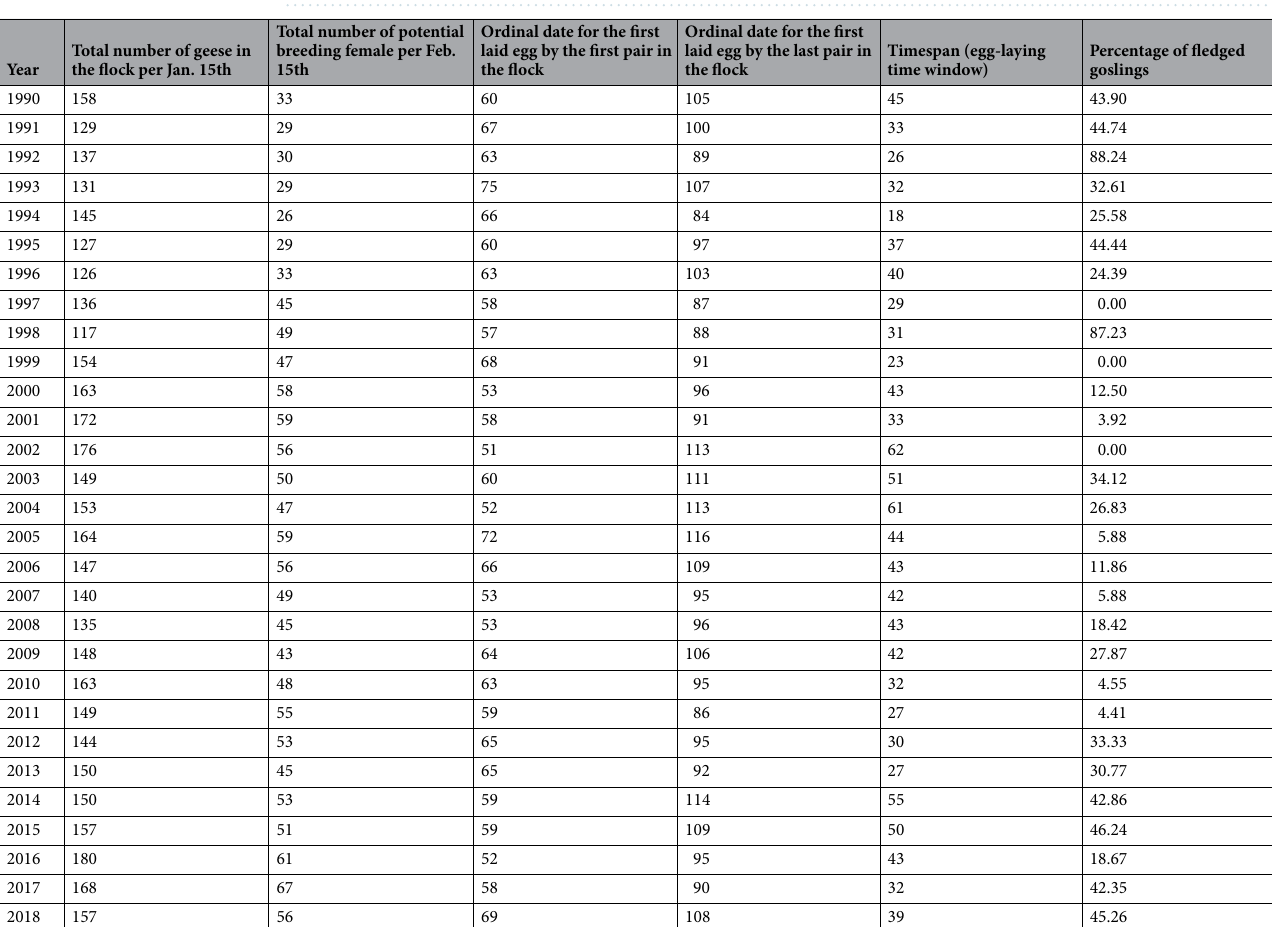
Table 5. Information about the breeding events (ordinal date of the first and last laid egg) and productivity (percentage of fledged goslings) per year of